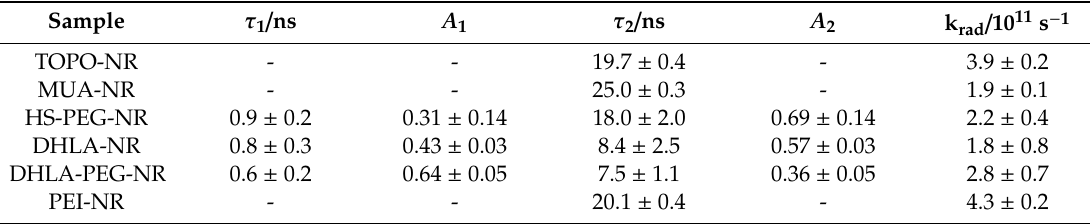
Table 2. Time-resolved photoluminescence spectroscopy on NR with different surface ligands. Time constants were obtained via a mono- or biexponential fit. For the biexponential fits, the amplitudes of the respective component are indicated. Additionally, the rate of radiative recombination k rad , which was calculated from eq. 1 using τ 2 , is also given.